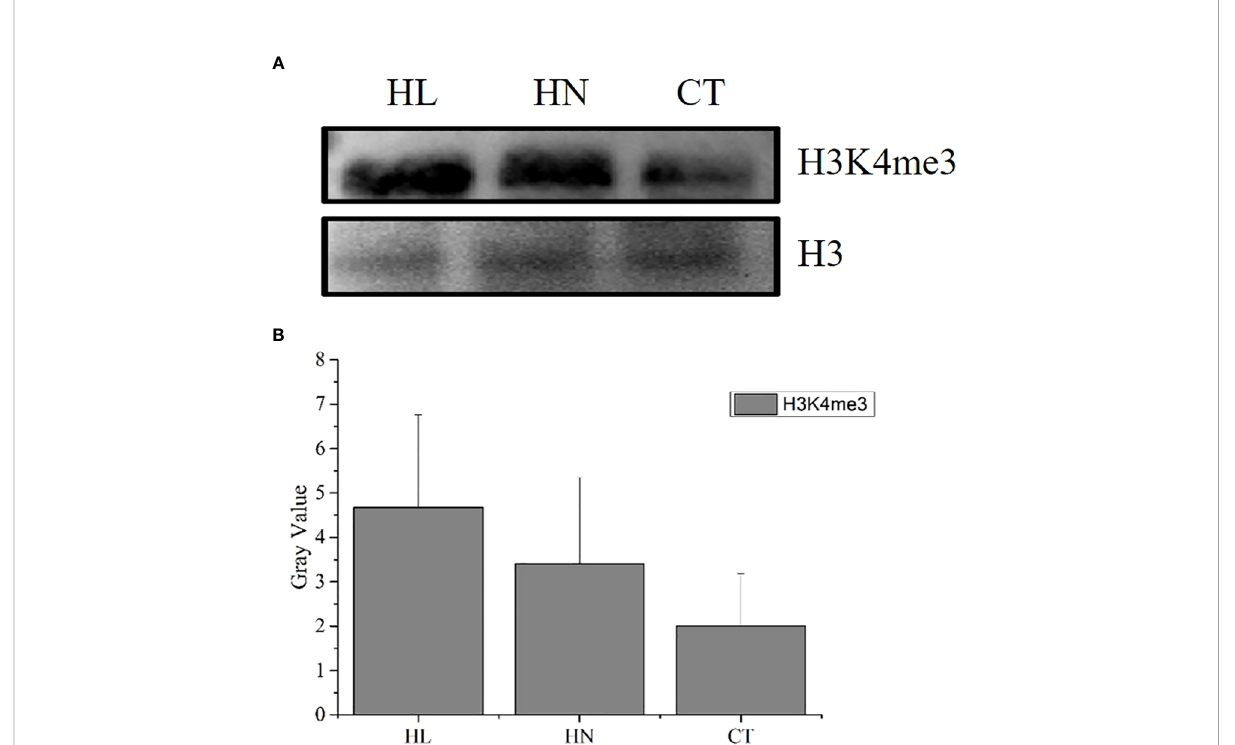
FIGURE 2 H3K4me3 abundance detection of Alexandrium paci fi cum under different conditions. (A) Western blot results of H3K4me3 modi fi cation in A paci fi cum under HN, HL, and CT; (B) Bar graph of the blot-spot density. Each column is the mean of three independent experiments,